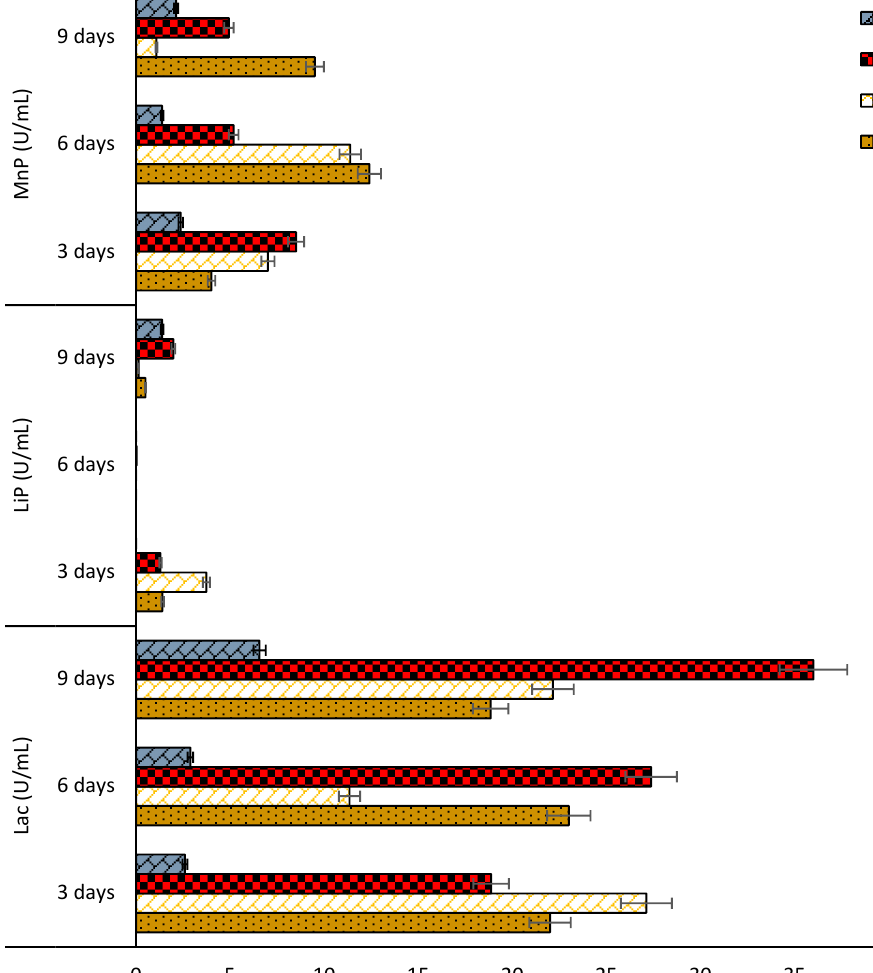
Figure 5. Activities of extracellular enzymes produced by Aspergillus oryzae C-Effurun isolated from a crude oil polluted site in Nigeria.